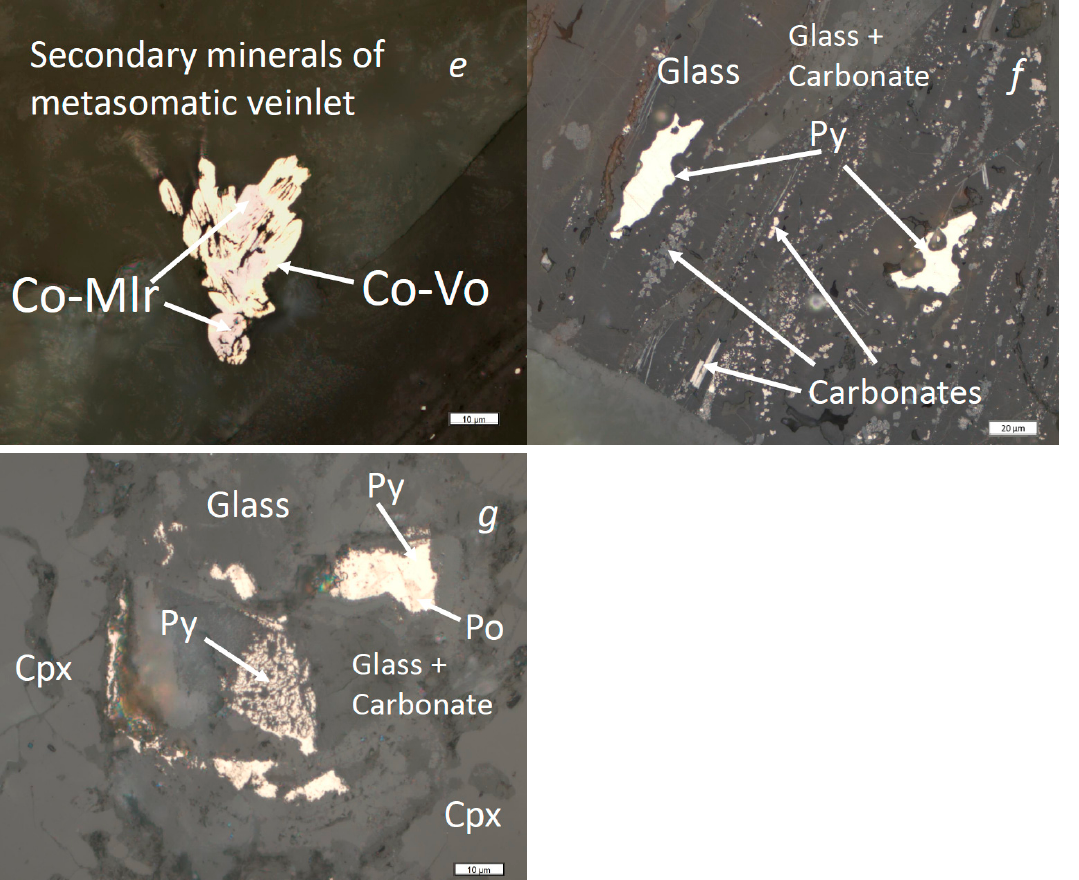
Figure 5. Reflected light photomicrographs of sulfide structural types from Spl-Grt lherzolites: ( a ) three-phase roughly rounded sulfide inclusion (e-type) in Ol. The main body consists of slightly cleaved Pn with Ccp developed along the cleavage cracks. Rare patches of Pld are present at the edges of the inclusion. The scale bar is 10 μ m; ( b ) big irregular sulfide inclusion (e-type) in a kelyphite aggregate. The main volume of the sulfide inclusion is represented by massive Po with flame-like exsolution lamellae of Pn. Massive Pn is developed at the edges of the sulfide inclusion. Insignificant amount of massive Ccp is developed at the edges of the sulfide grain. The scale bar is 20 μ m; ( c ) roughly rounded interstitial sulfide (i-type). The main body consists of slightly cleaved Pn with Ccp developed along the cleavage cracks. Rare patches of massive Ccp are present at the resorbed edges of the sulfide grain. Pld patches are present along the edges of the sulfide grain. Small grains of Fe oxides/hydroxide are developed around the sulfide. The scale bar is 10 μ m; ( d ) irregular interstitial sulfide (i-type). The main body consists of slightly cleaved Pn with Ccp developed along the cleavage cracks. Massive Ccp is developed at the edges of the sulfide grain. Glass (loci of former silicate melt) is present at the resorbed edge of Cpx. The scale bar is 10 μ m; ( e ) skeletal Co-violarite (Vo) + Co-Mlr crystal (m-type sulfide) in a metasomatic veinlet. The scale bar is 10 μ m; ( f ) sulfides in a metasomatic carbonate-glassy patch. Irregular blebs of massive pyrite (Py) are clearly seen (m-type sulfide). Tiny crystals of carbonate are present within uncrystallized glassy and carbonate materials. The scale bar is 20 μ m; ( g ) assemblage of resorbed and massive sulfides in a metasomatic carbonate-glassy patch (m-type sulfides). Sulfides are represented by bi-mineral (Po + Py) massive grains and faceted monomineral (Py) grains. The scale bar is 10 μ m.